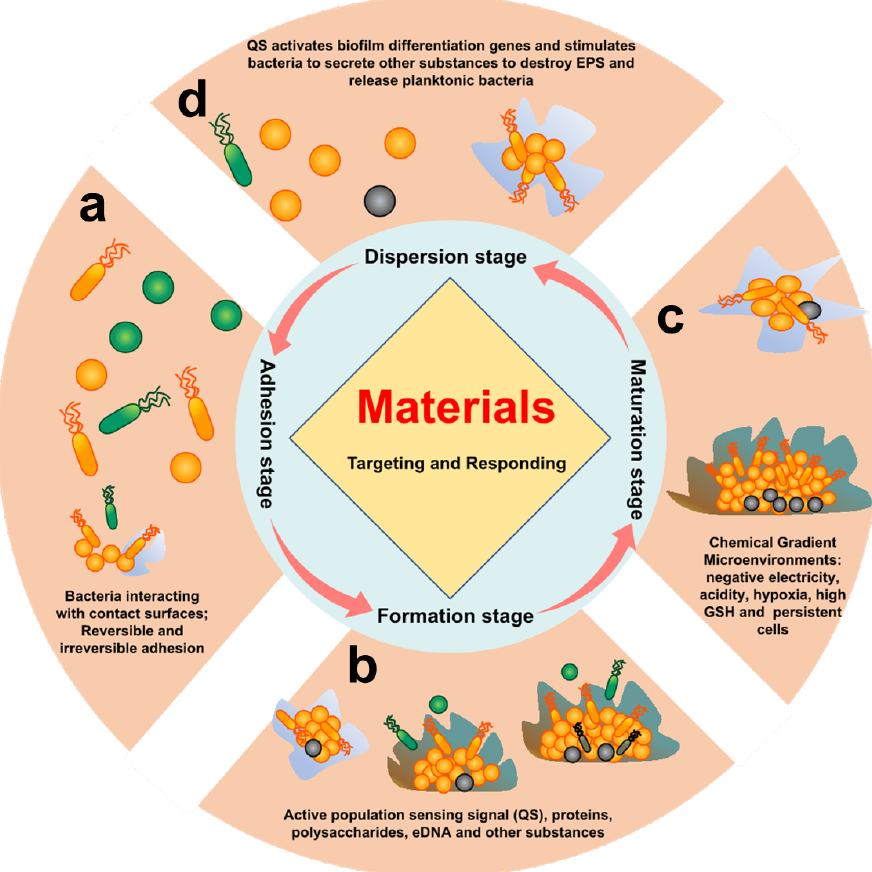
Figure 1. The biofilm life cycle. Different stages of bacterial biofilm formation. ( a ) Initial adhesion, in which bacteria adhere to surface of tissue through their own adhesins of bacteria; ( b ) early biofilm development stage, whereby the bacteria begin to divide and produce EPS by quorum sensing, eDNA, polysaccharide, and protein; ( c ) biofilm maturation stage, in which the biofilm will form a stable 3D structure through EPS, and the internal microenvironment exhibits a certain chemical gradient, such as acidity, hydrogen peroxide (H 2 O 2 ), hypoxia, and overexpressed glutathione (GSH); ( d ) biofilm dispersion stage, whereby bacteria are oppressed by the extreme microenvironment, and their own secreted enzymes and D-type amino acids lyse the biofilm and return to the state of planktonic